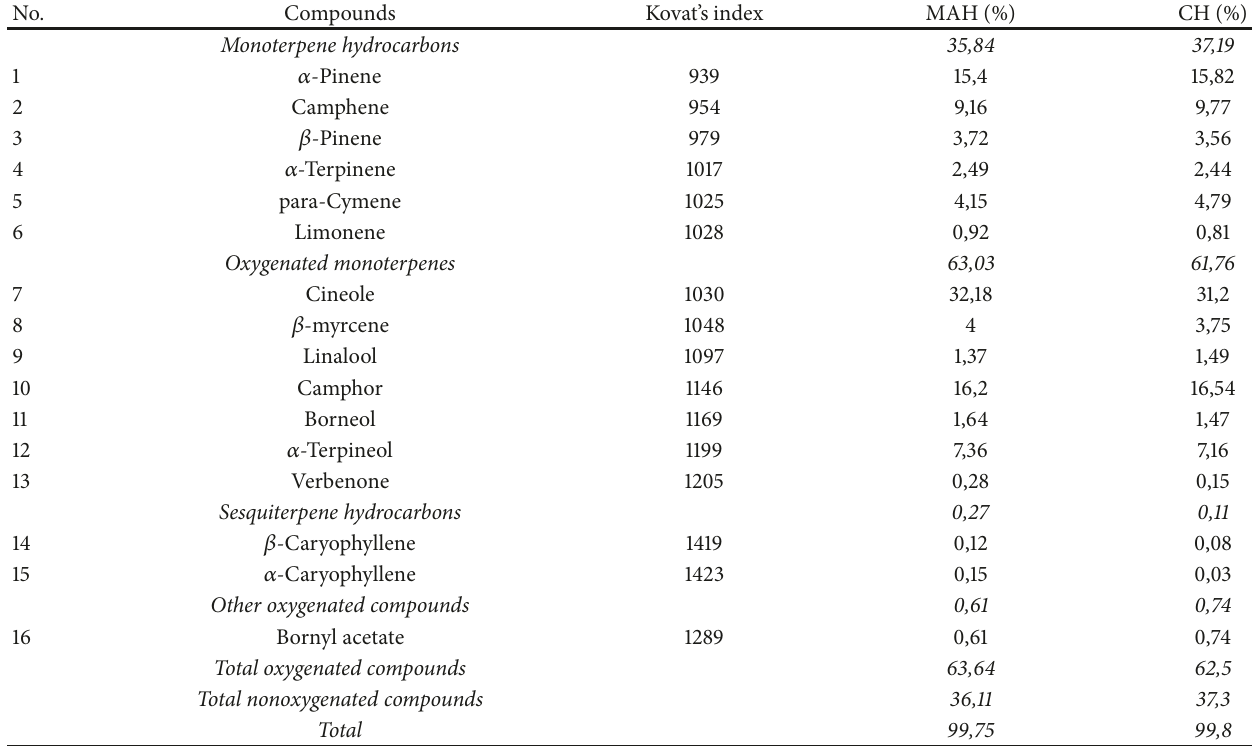
Table 2: Chemical composition of rosemary essential oils obtained by CH and MAH.